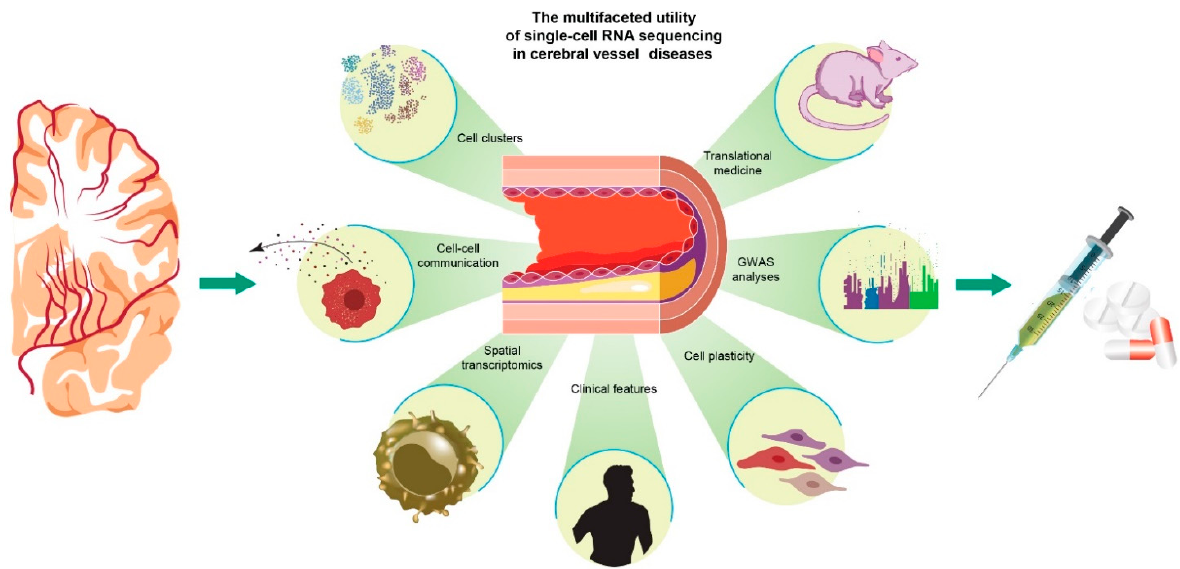
Figure 1. The multifaceted utility of single-cell RNA-seq in cerebral vessel diseases. scRNA-seq can be employed to unravel several features of cerebral vessel disease and the pathogenesis of atherosclerosis. This technology can reveal the cellular composition of a lesion, provide information on lineage tracing and cell evolutionary trajectory, and be applied to investigate cellular plasticity and clonality phenomena and match the expression contributions of individual cells to GWAS risk factors. Spatial transcriptomics might localize distinct cell populations in the vessels and plaques and elucidate their communication interplay. scRNA-seq can illuminate at the single-cell level the molecular features of different cerebrovascular disease clinical presentations and promote pathogenetic and therapeutic translational studies from animal models to